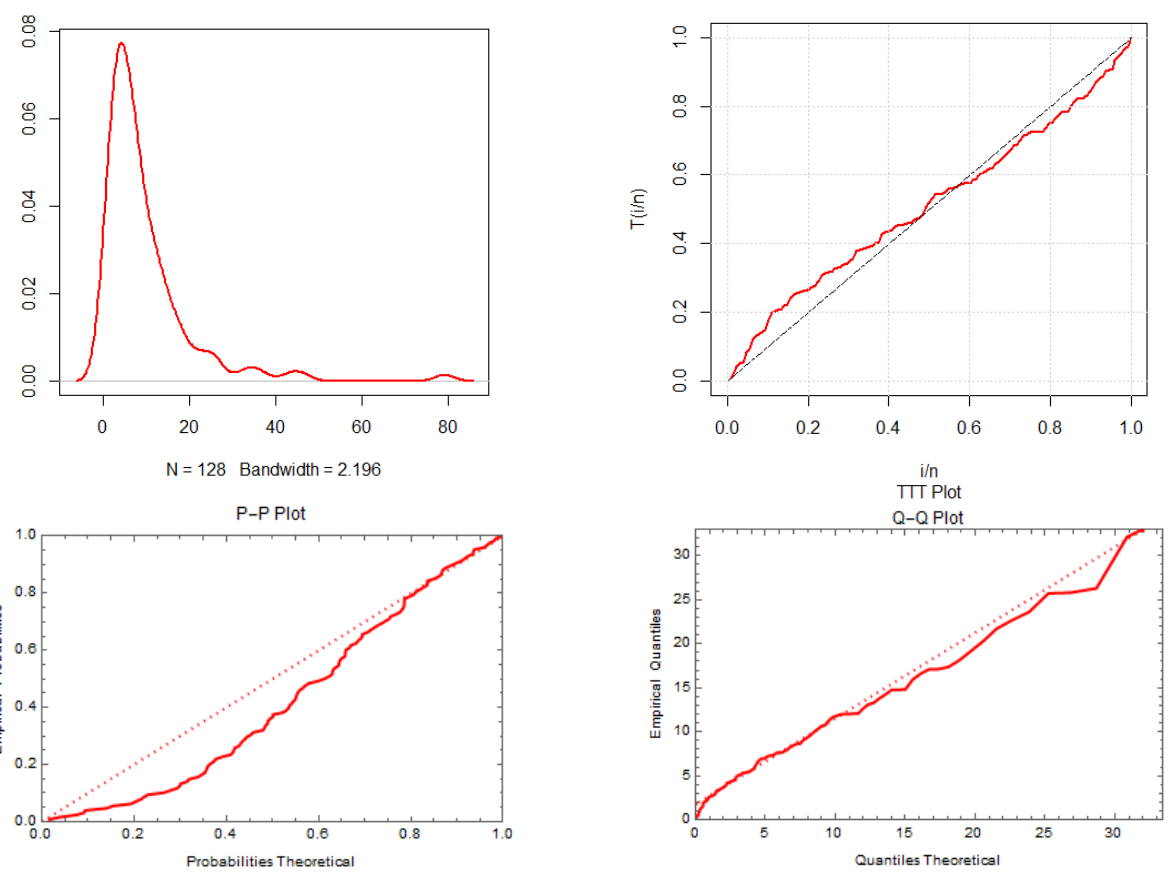
Figure 10. The density, TTT, P–P, and Q–Q plots of the PZD for bladder cancer patients’ data.